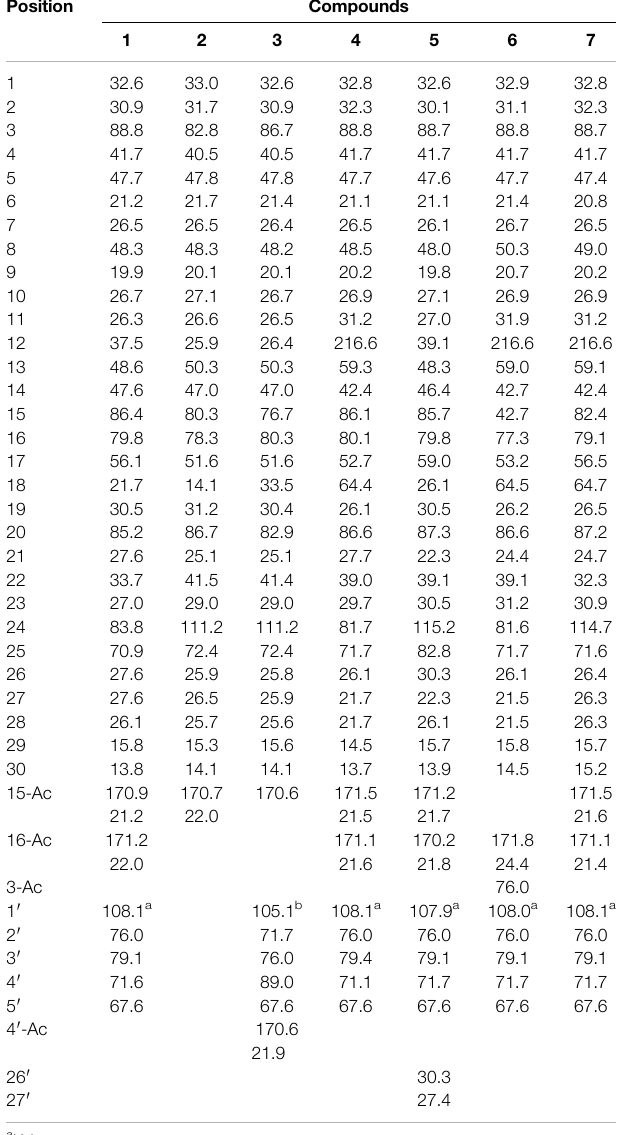
TABLE 2 | 13 C NMR Data (150 MHz, in pyridine- d ppm, J in Hz).